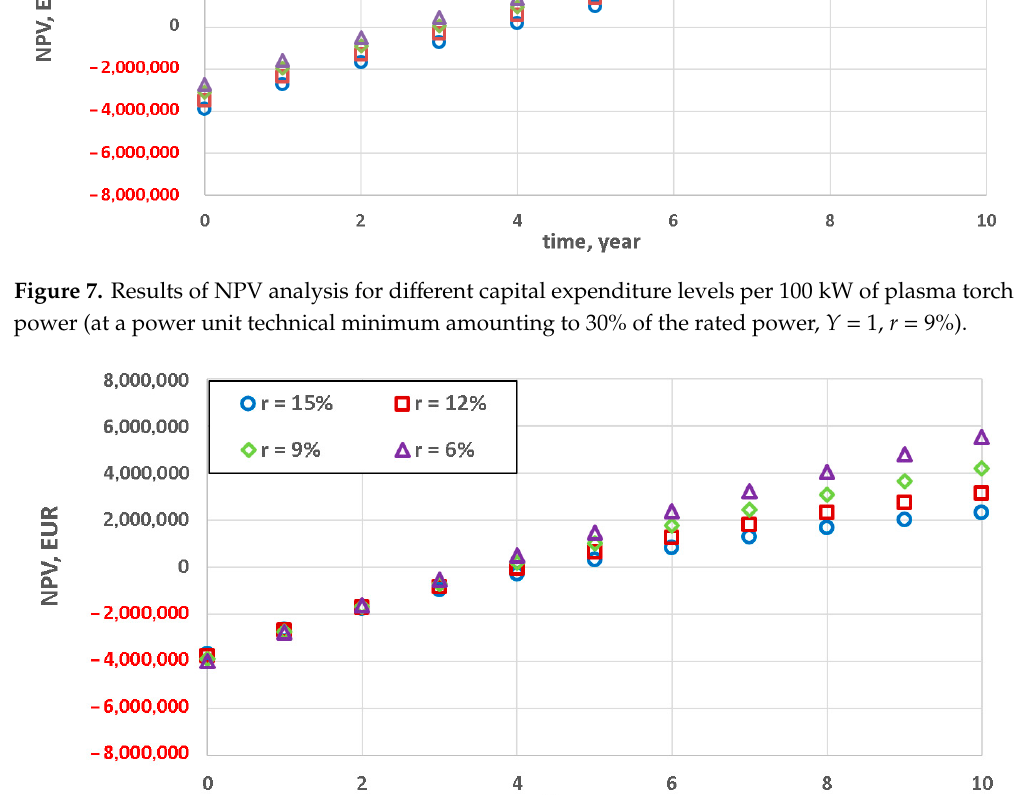
Figure 7. Results of NPV analysis for different capital expenditure levels per 100 kW of plasma torch power (at a power unit technical minimum amounting to 30% of the rated power, Y = 1, r = 9%).